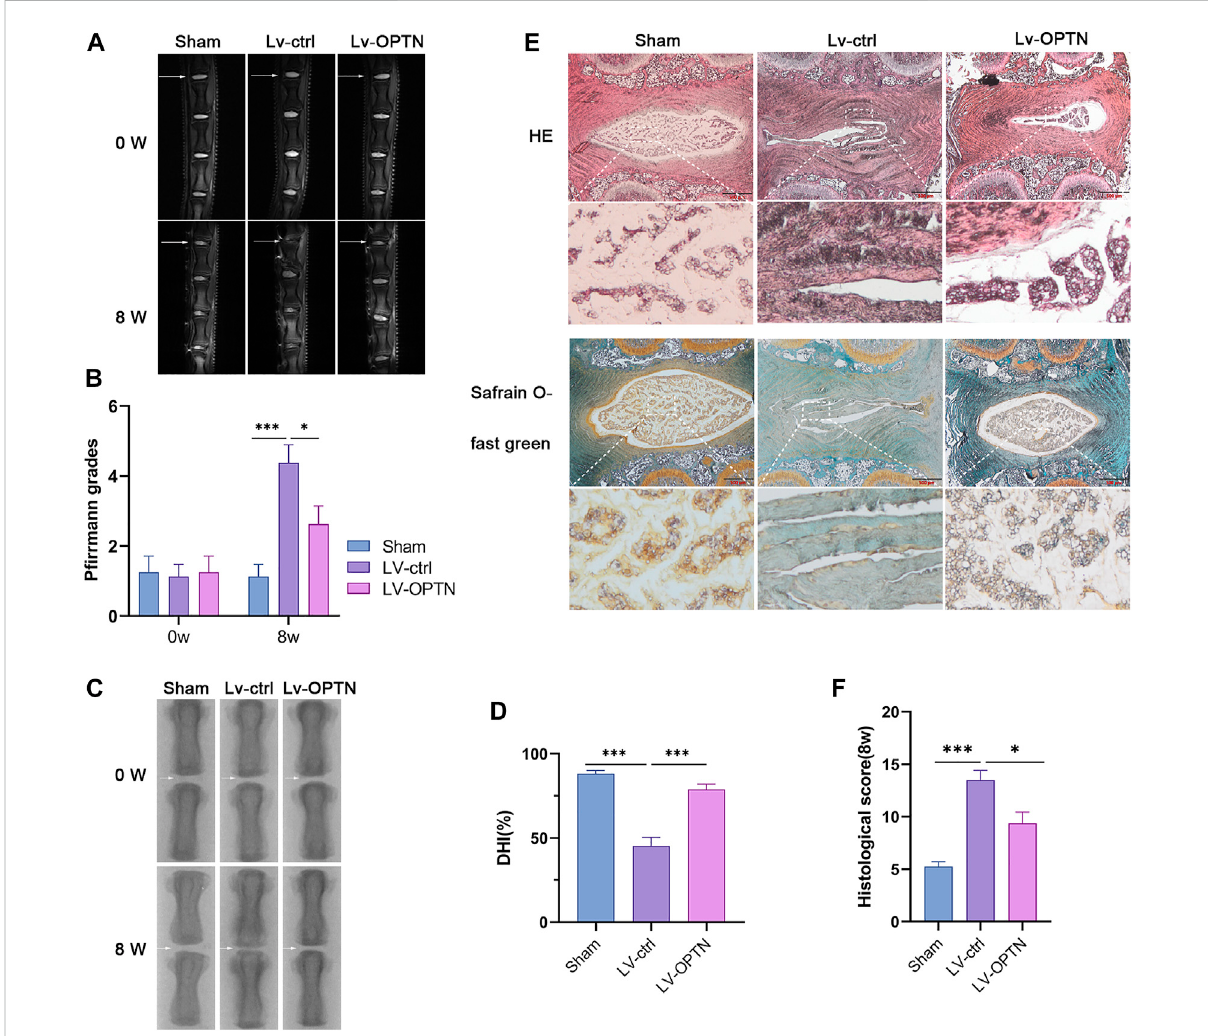
FIGURE 6 UpregulationofOPTNalleviatedIVDDinrats. (A – B) MRIandP fi rrmanngradeofrattaildiscsat0and8 weeksaftersurgery(whitearrows). (C – D) The X-ray and DHI% of rat tail discs at 8 weeks after surgery. (E – F) Representative HE, Safranin O-fast green staining of NP tissues and histological grades evaluated at 8 weeks in each group. All experiments were performed as means ± SD of 3 times in duplicates. ( n = 10). * p < 0.05, ** p < 0.01, *** p < 0.001, ns p >